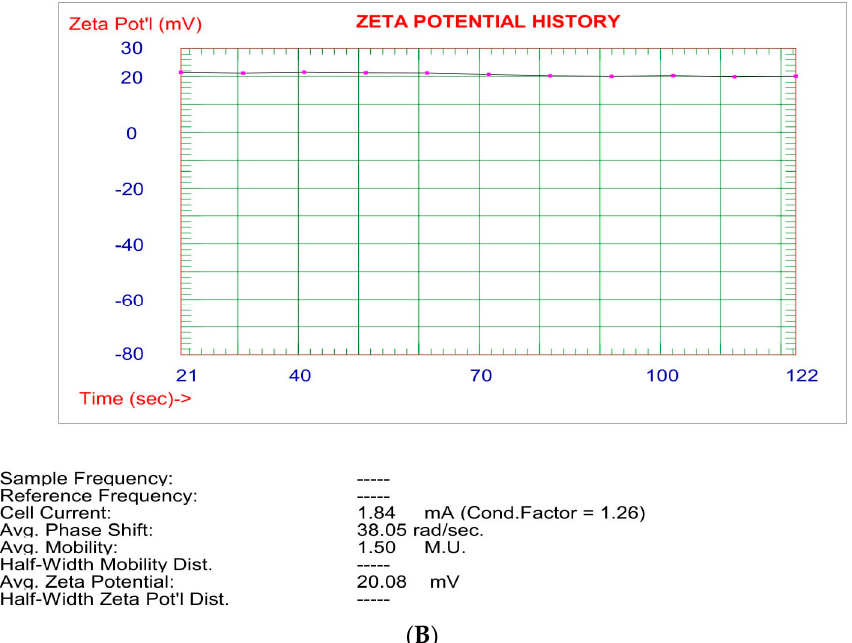
Figure 6. The particle size distribution curve ( A ) and zeta potential ( B ) of the optimized MIC TRANSFEROSOME formulation (F5).